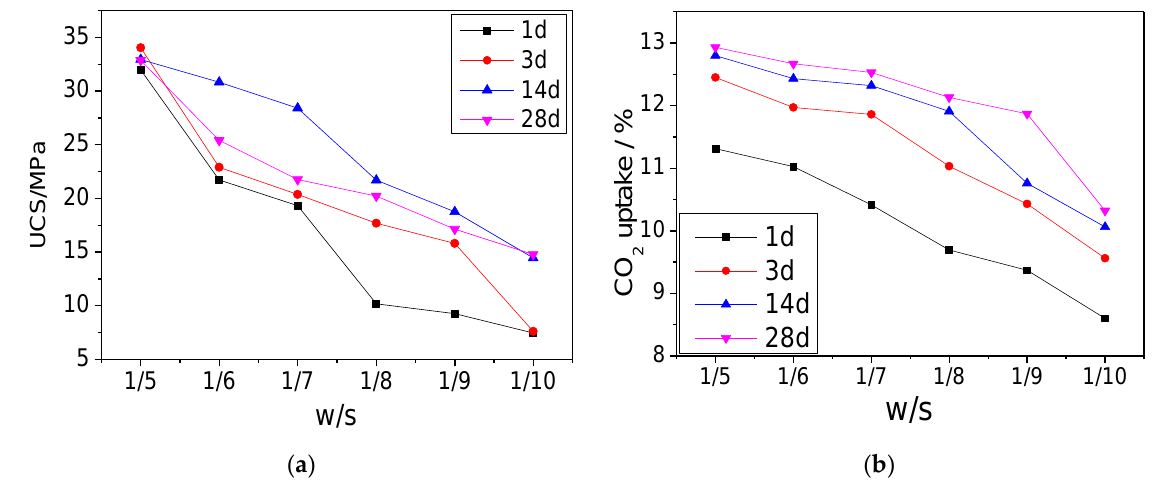
Figure 12. ( a ) UCS and ( b ) CO 2 uptake results for samples with different w/s values.